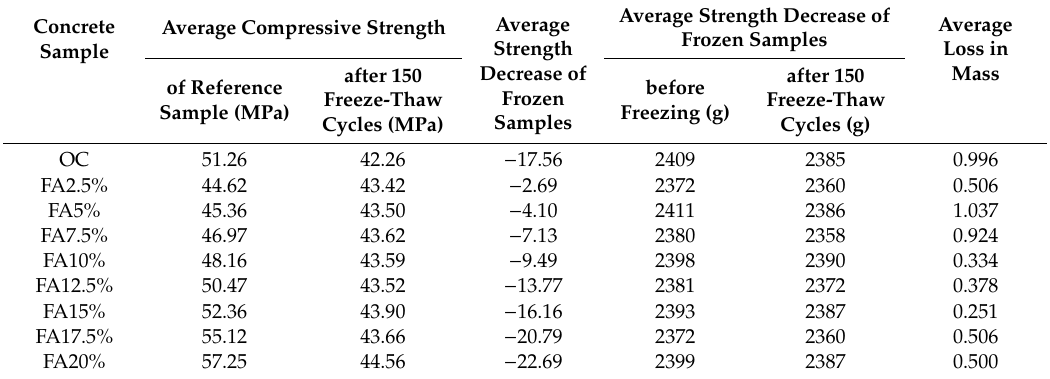
Table 5. Average decrease in compressive strength and average loss in mass of samples subjected to